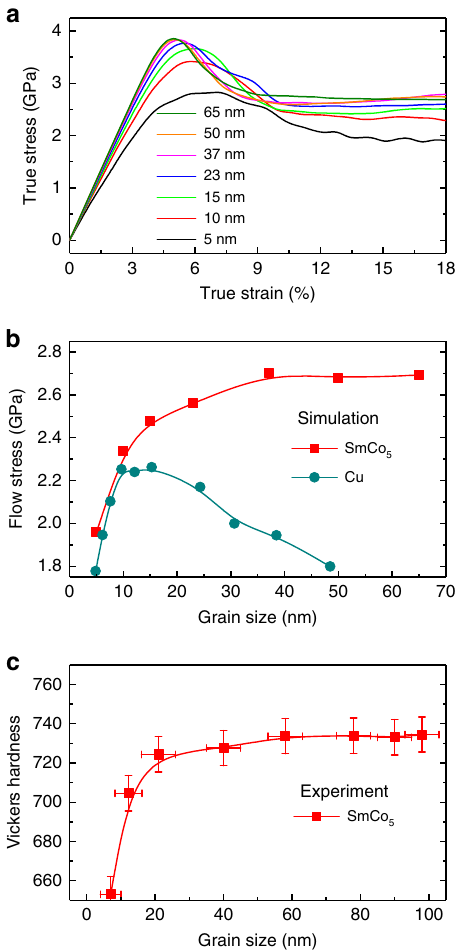
Fig. 1 Mechanical behavior of SmCo 5 as a function of grain size. a Simulated stress – strain curve of SmCo 5 with different grain sizes under uniaxial compression at strain rate of 10 8 s − 1 . b Flow stresses of simulated SmCo 5 and Cu. Data for Cu are results of tensile simulation at a strain rate of 5 × 10 8 s − 1 and are adapted from ref. 9 . The fl ow stress for SmCo 5 is calculated from ( a ) for strains larger than 10.5%. c Experimentally measured Vickers hardness of SmCo 5 as a function of grain size (see Methods). The error bars represent deviations of grain size and hardness from their